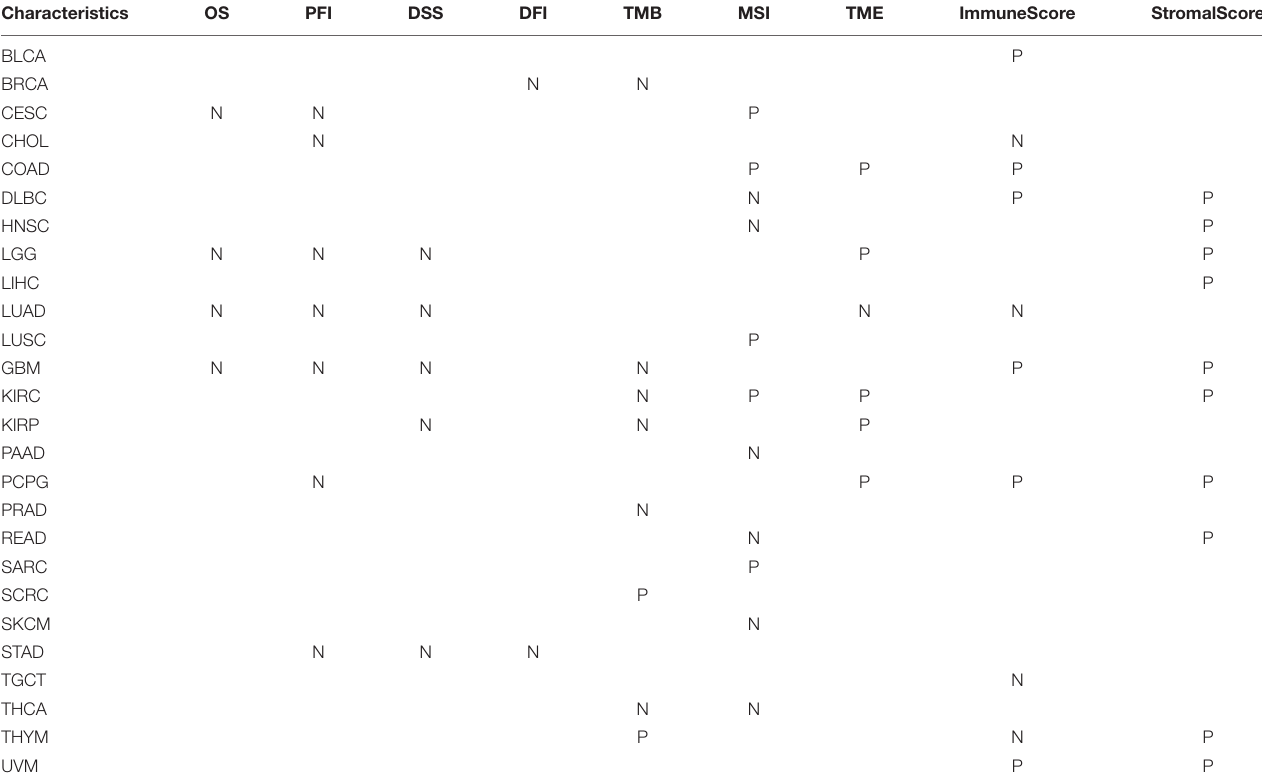
TABLE 1 | Overall information of FURIN in human